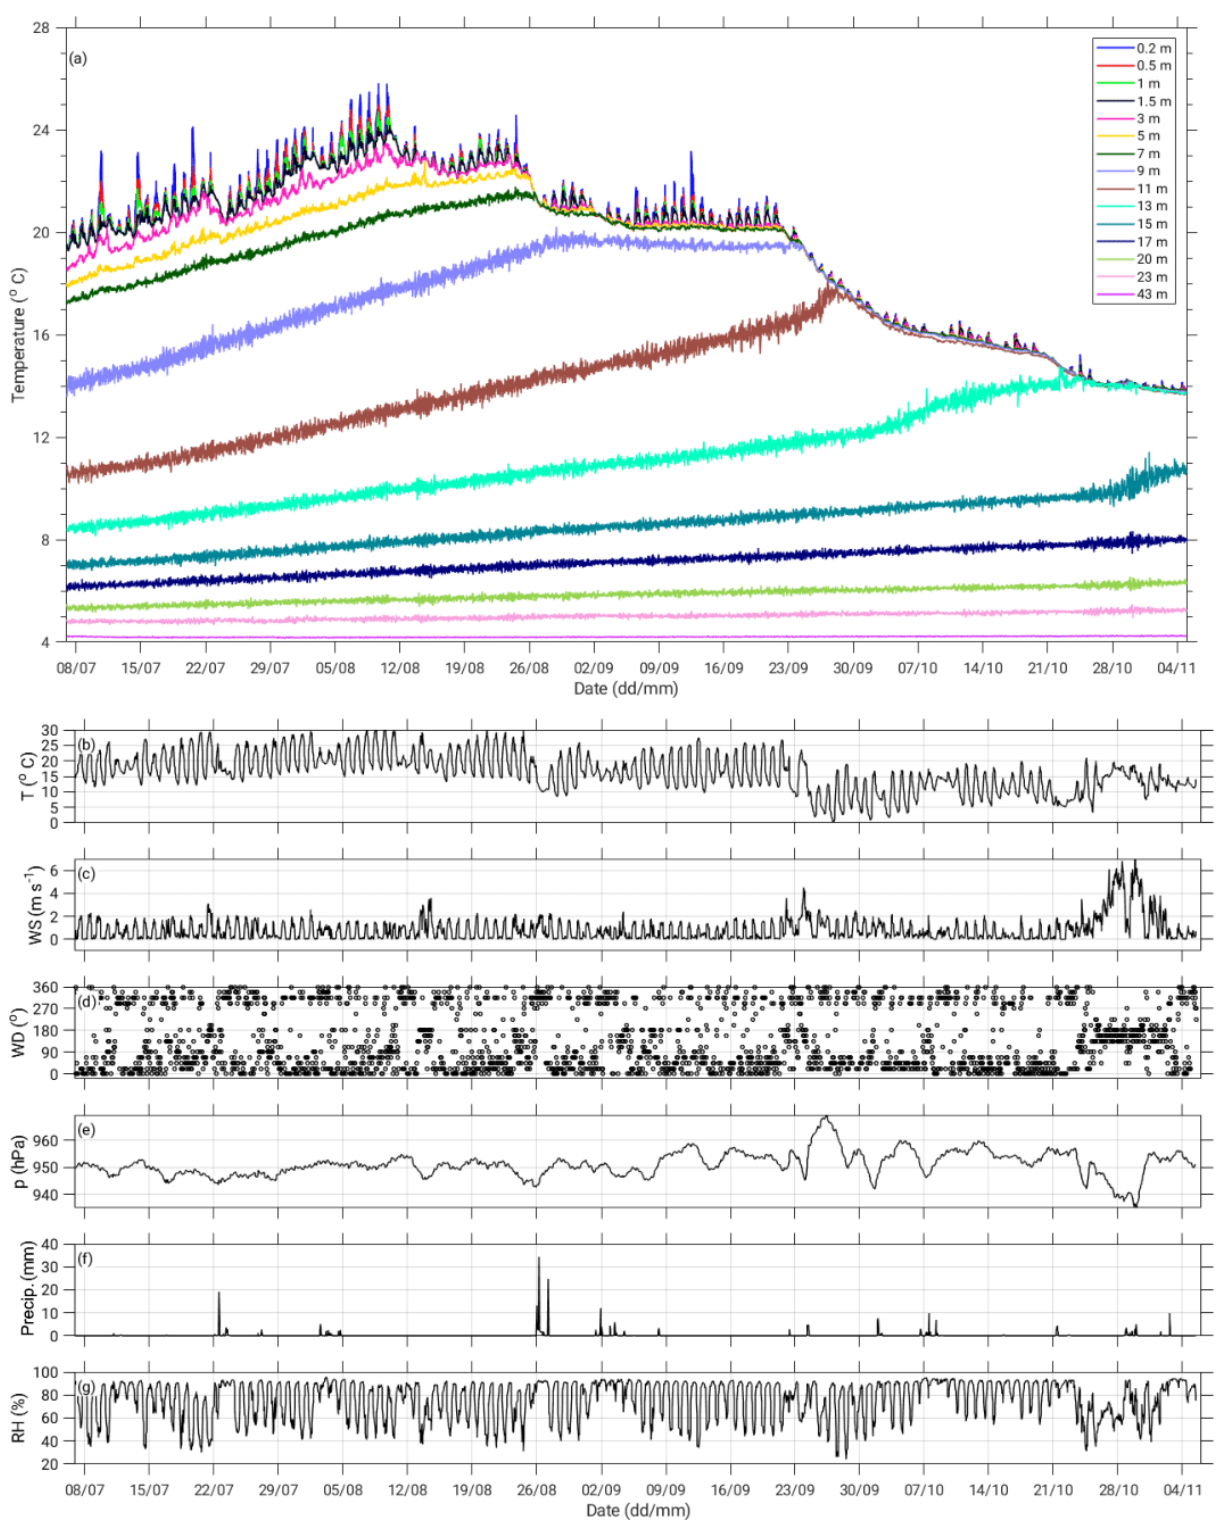
Figure 2. Observed 2min mean lake temperatures at various depths from 0.2 to 43m during the period from 7 July to 5 November 2018 (a) and simultaneous hourly values of the air temperature (b) , wind speed (c) , wind direction (d) , air pressure (e) , precipitation amount (f) , and relative humidity (g) . Measuring point positions are depicted in Fig. 1 (right